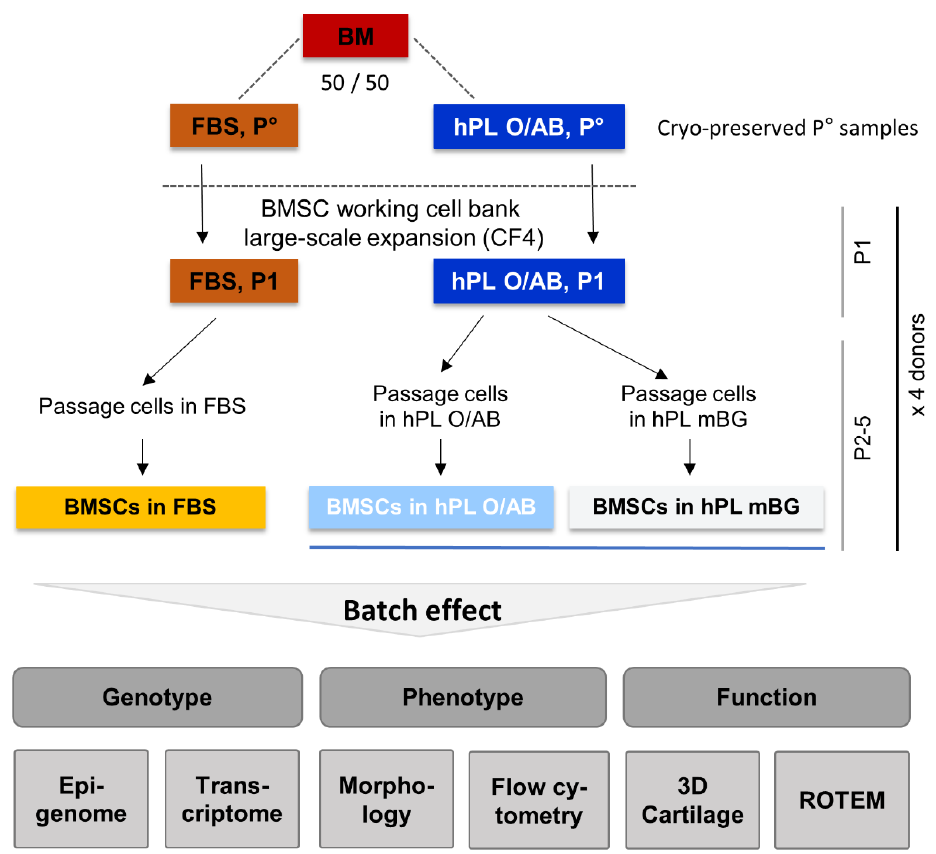
Figure 1. Study outline showing bone marrow stromal cell (BMSC) propagation from human bone marrow samples. Bone marrow (BM) from four healthy donors was divided 50/50 (e.g., 2 × 2.5 mL) and resuspended directly in 500 mL culture medium supplemented with either fetal bovine serum (FBS) or pooled human platelet lysate (hPL) to initiate primary culture (P°) [23]. P° and passage 1 (P1) cultures were performed with a selected lot of FBS or with hPL from blood group O donor platelets, lysed in blood group AB plasma, lacking isoagglutinins anti-A and anti-B (hPL O/AB), in four-layered cell factories (CF4), to establish a working cell bank. In subsequent cultures, hPL derived from expired platelet concentrates irrespective of the blood group (mixed blood group, mBG) was used for comparison as indicated. The batch effect of these different culture conditions on BMSC genotype, phenotype and function was studied as indicated. ROTEM, rotational thromboelastometry.